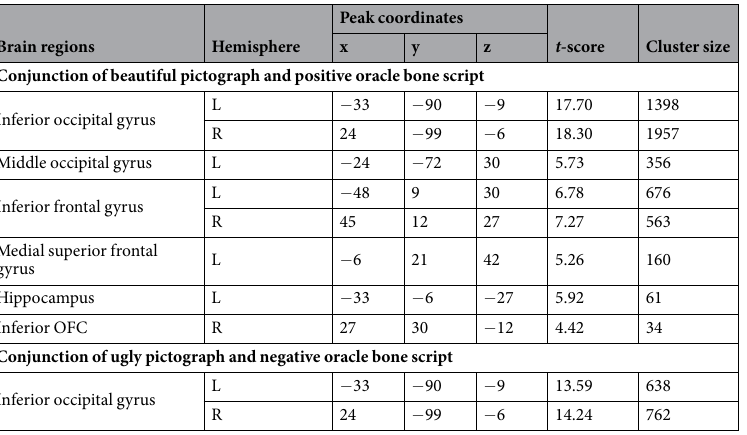
Table 3. Activations in the conjunction analysis between pictographs and oracle bone scripts. Note: Coordinates refer to the stereotactic space of the Montreal Neurological Institute. The statistical significance refers to p < 0.001 at voxel level (uncorrected), p < 0.05 at cluster level (FWE corrected).